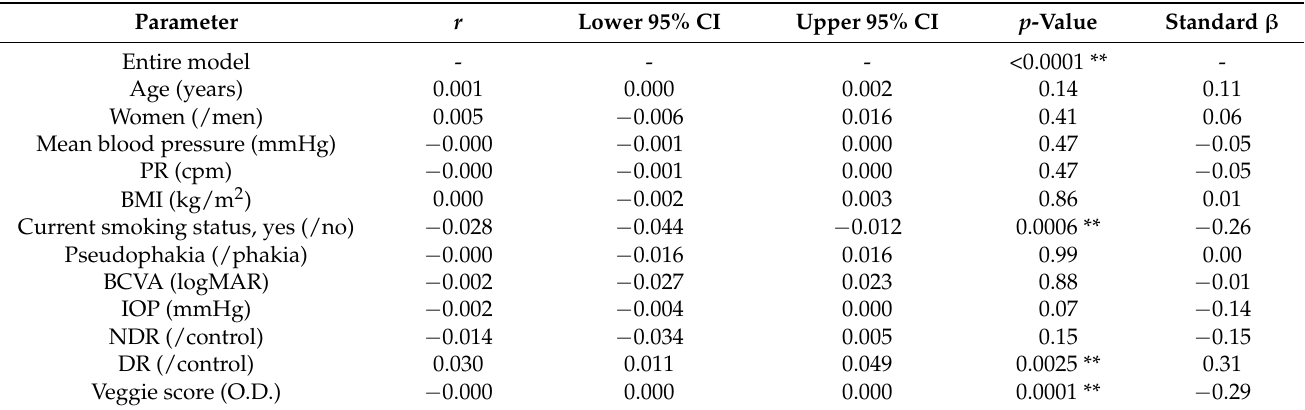
Table 9. Possible associations among AGEs scores (A.U.) and various parameters analyzed by multiple regression